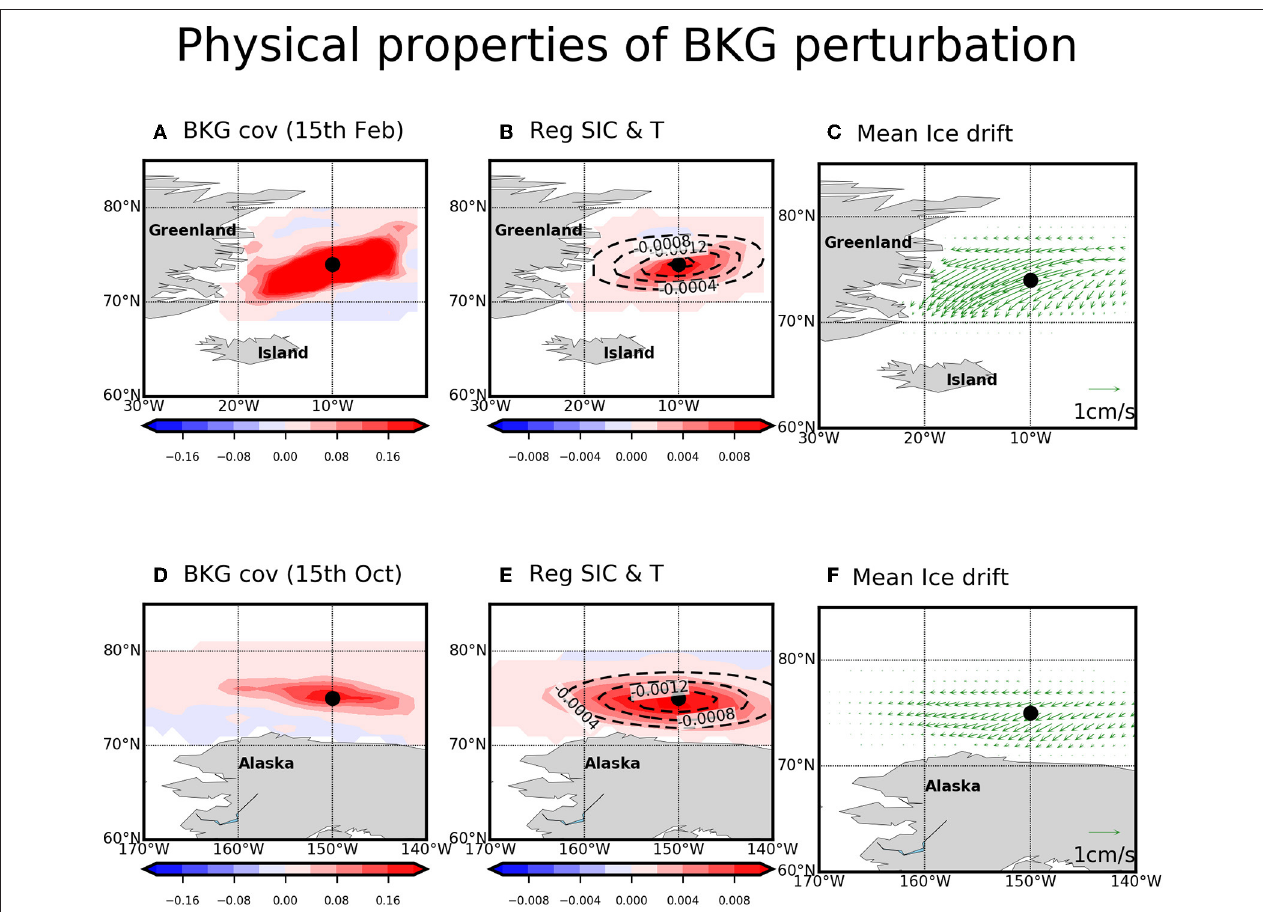
FIGURE 3 | The covariance patterns (A,D) in forecast error perturbations of sea ice concentration (a fraction from 0 to 1) generated by using long-time integration, the regression patterns [shaded for sea ice concentration and contour for sea surface temperature ( ◦ C); B,E ], and mean sea ice drift (cm/s; C,F ) in model long-time integration outputs during 1982–2019. The covariance and regression patterns between a selected grid point ( A–C : 75N, 10W in Greenland Sea; D–F : 75N, 150W in Beaufort Sea) and global grid points are left and middle column. The upper (lower) panels are results at 15th February (October). All the plots are localized using quasi-Gaussian weight function with localization radius of